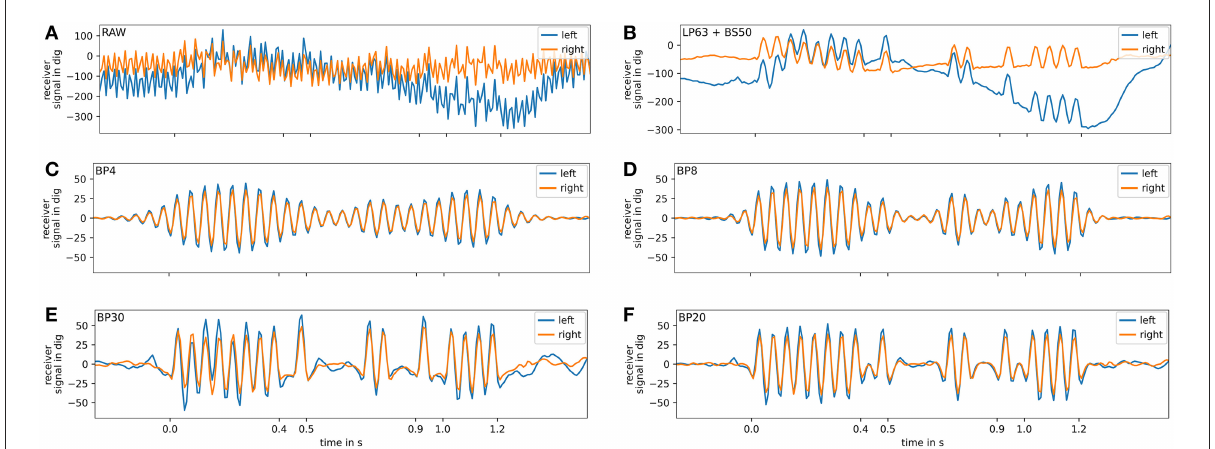
FIGURE9 Matched landmark packets of two receivers worn at the left (blue) and right wrist (orange). Raw, unfiltered measurements (A) . Interference-reduced signal (IRS) after anti-alias filtering (LP) and power line noise rejection (BS) with contained data 00001100 2 (MSB first) visible (B) . Applied filter bandwidths B of 4Hz (C) , 8Hz (D) , 20Hz (E) , 30Hz (F) . Best result regarding fast transient response, pulse-to-gap ratio, as well as minimal interference and baseline wander for a B of 20Hz (E) .